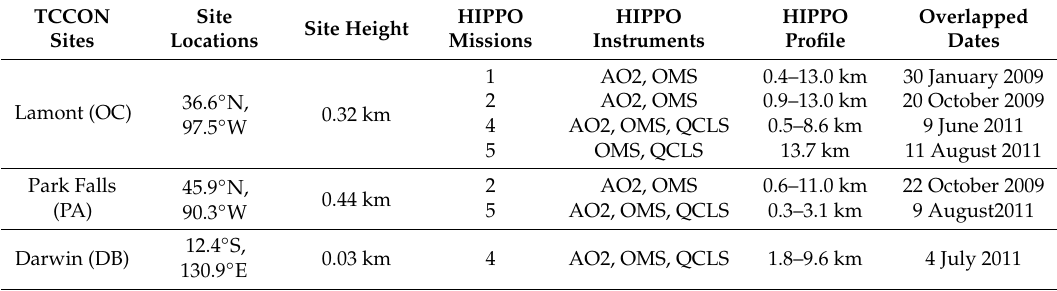
Table 4. HIPPO flights over TCCON sites. The TCCON site, HIPPO missions, locations, TCCON site height, altitude range of the HIPPO profiles and overlap dates are listed.